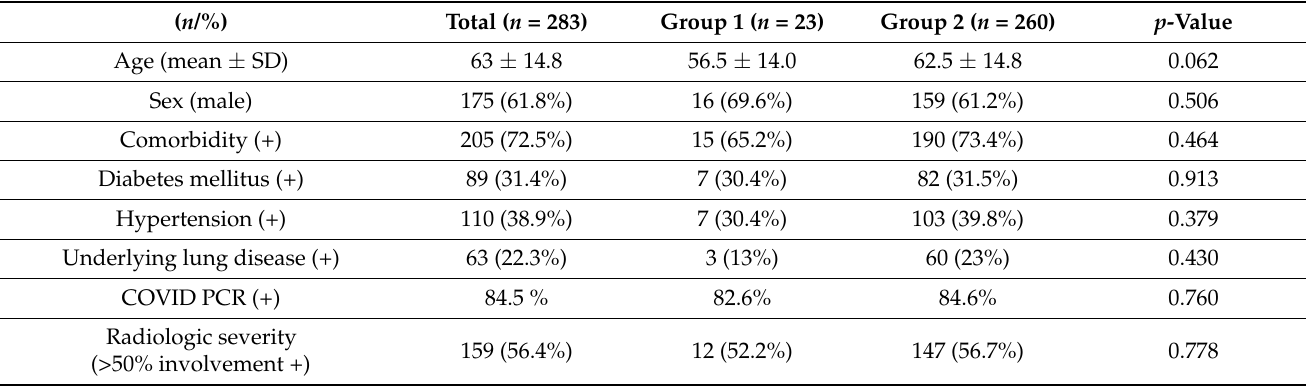
Figure 1. Flowchart of the study (IMCU: intermediate intensive care unit, PX: pneumothorax, PM: pneumomediastinum, TB: tuberculosis).